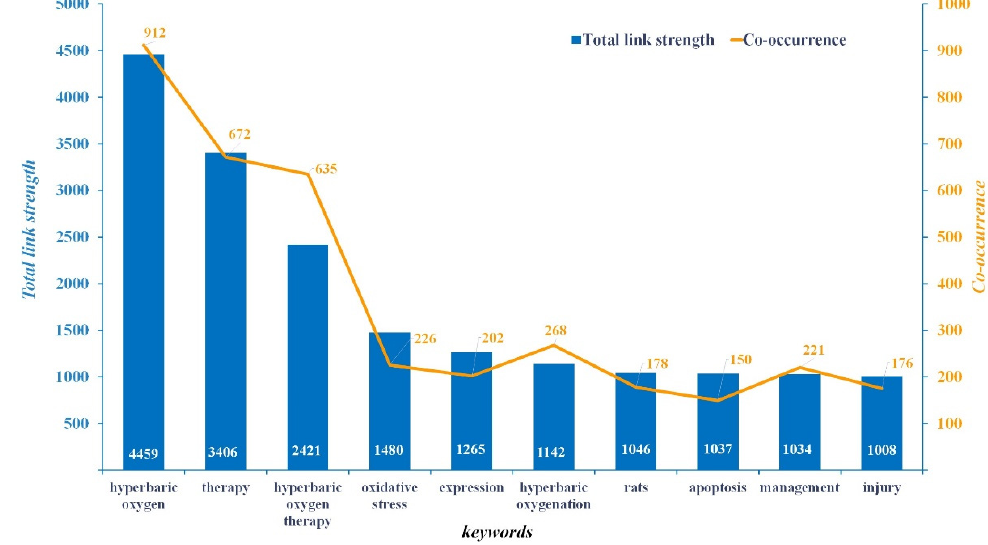
Figure 11. Keywords with the strongest occurrences and total link strength in HBOT research.